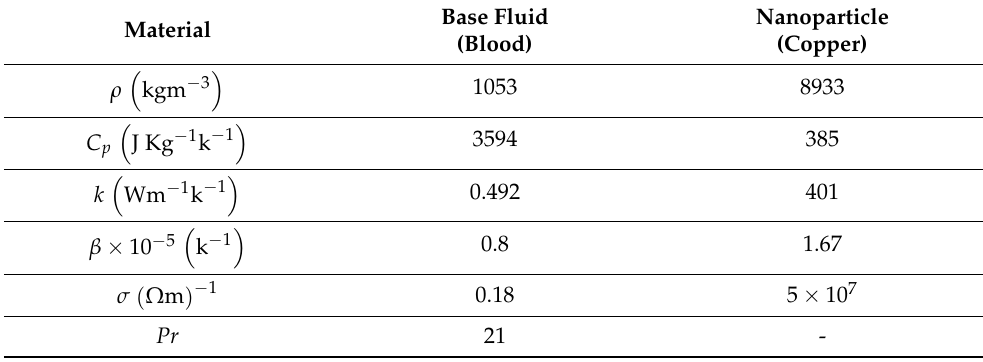
Table 1. Thermo-physical properties of blood and copper nanoparticles as given in [24]. Material